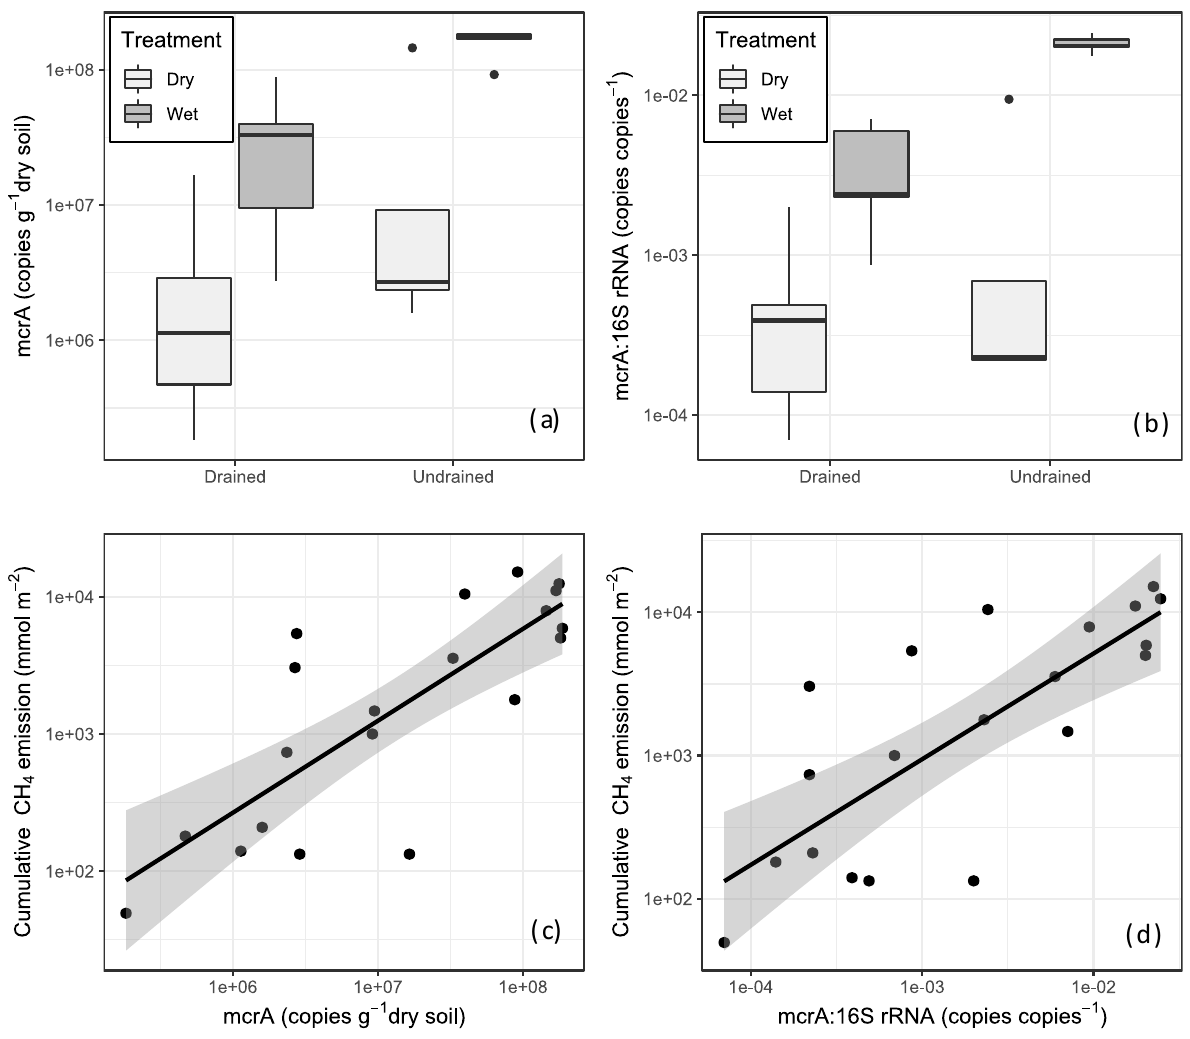
Figure 4. Absolute and relative methanogen abundances in unvegetated peat monoliths in relation to experimental treatments and cumulative CH 4 emissions. Panel (a): absolute methanogen (mcrA) abundance in relation to peat drainage history and water level treatment; panel (b): relative methanogen abundance (mcrA:16S rRNA) in relation to peat drainage history and water level treatment; panel (c): absolute methanogen (mcrA) abundance as a predictor of cumulative CH 4 emissions; panel (d): relative methanogen (mcrA:16S rRNA) abundance as a predictor of cumulative CH 4 emissions. All panels are on a log10-scale, panels c and d show regressions line with 95 % CI’s. Methanogen abundances were calculated as the mean values of two depths per monolith. Cumulative CH 4 emissions were estimated over a 84-day period by constructing AUC curves using biweekly flux